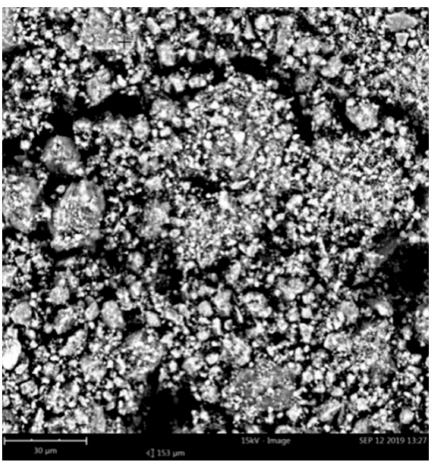
Figure 2. SEM of the residue after pretreatment.